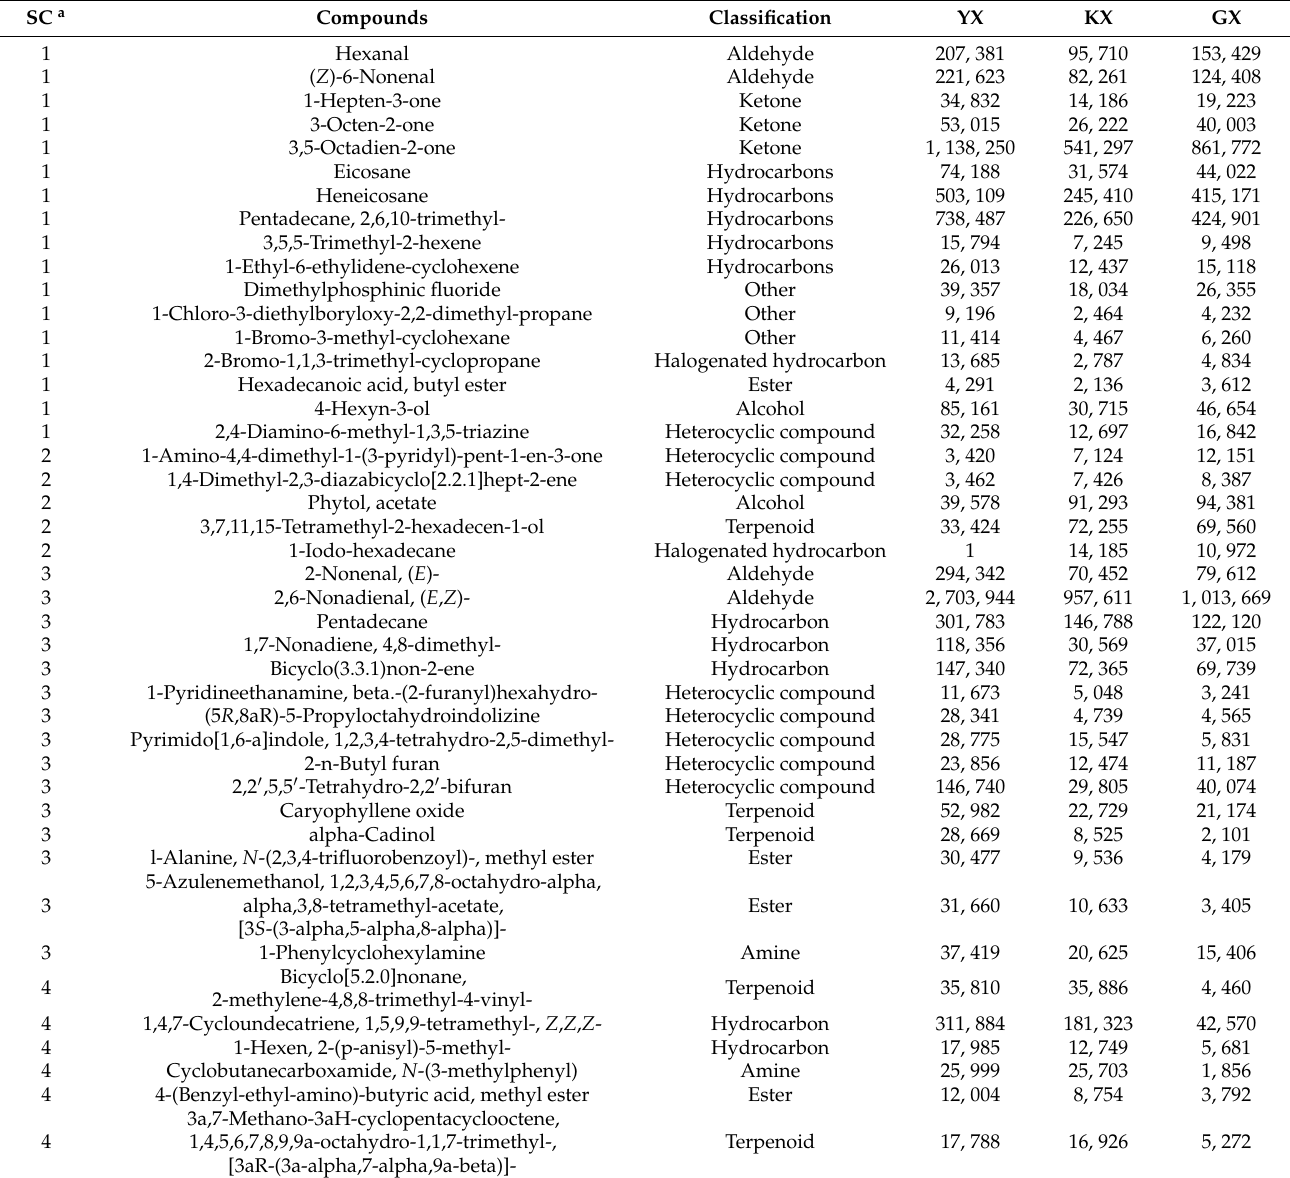
Table 2. K-means clustering metabolite